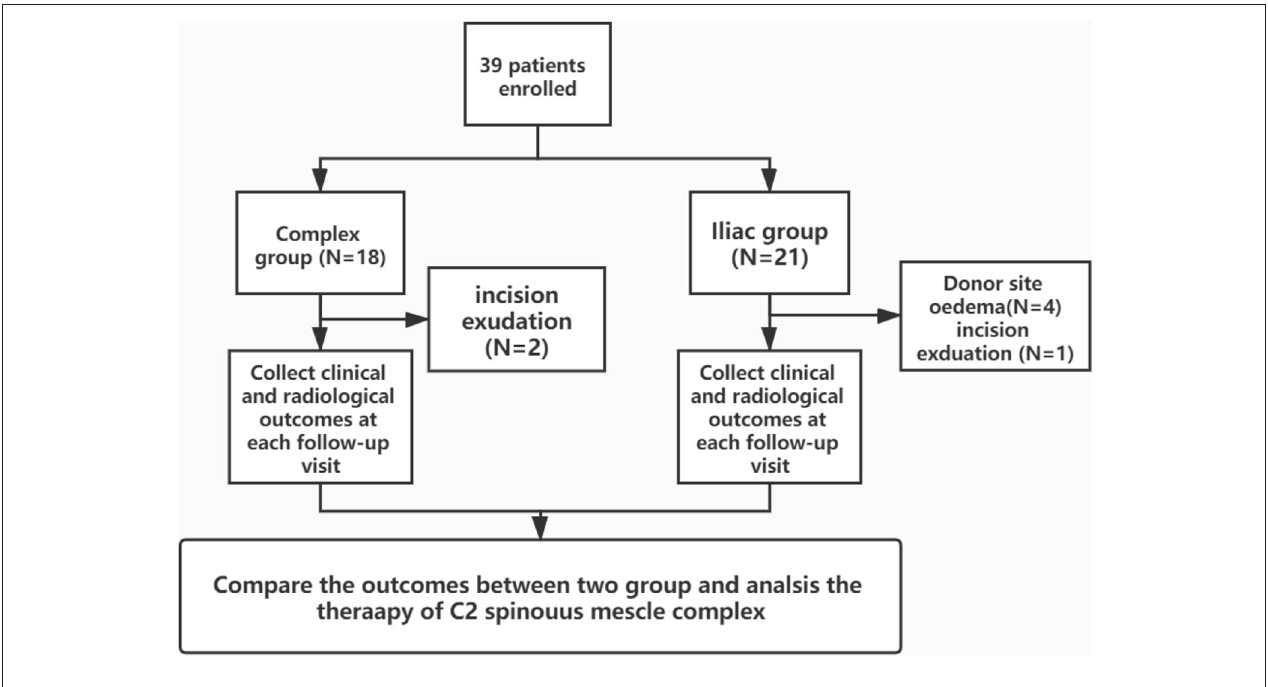
FIGURE 2 | The diagram of study flows.